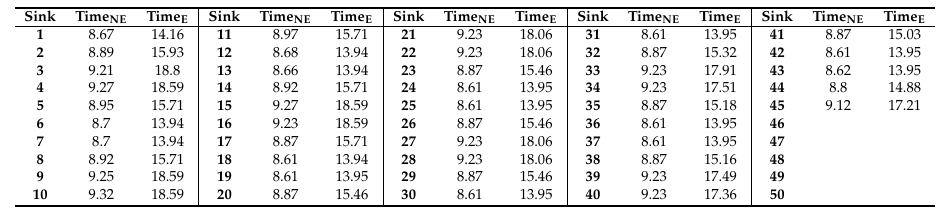
Table A4. Scenario 4: transmission times (in s) for each sink all over the transmission line. (Distance between poles is equal to 50 m, κ = 8, η = 3, NE means no encryption, E means encryption.)